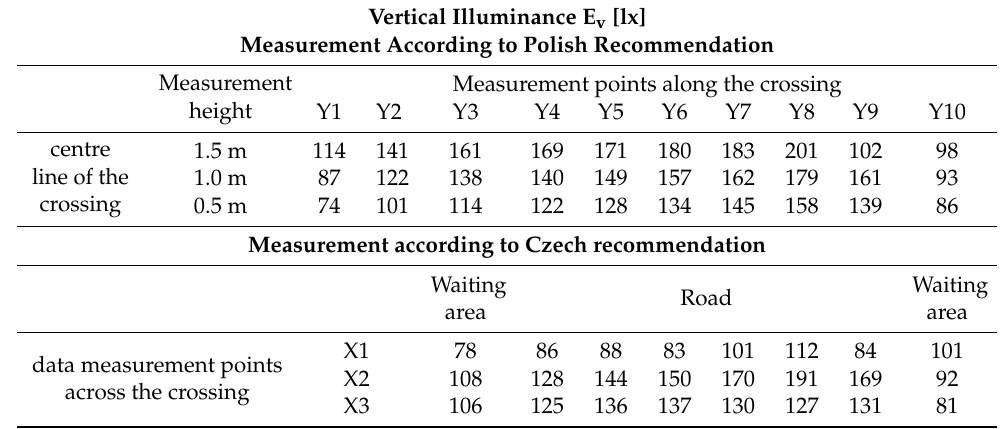
Table A2. Measurement results for the quality of illumination at pedestrian crossing no. 2—direction A.